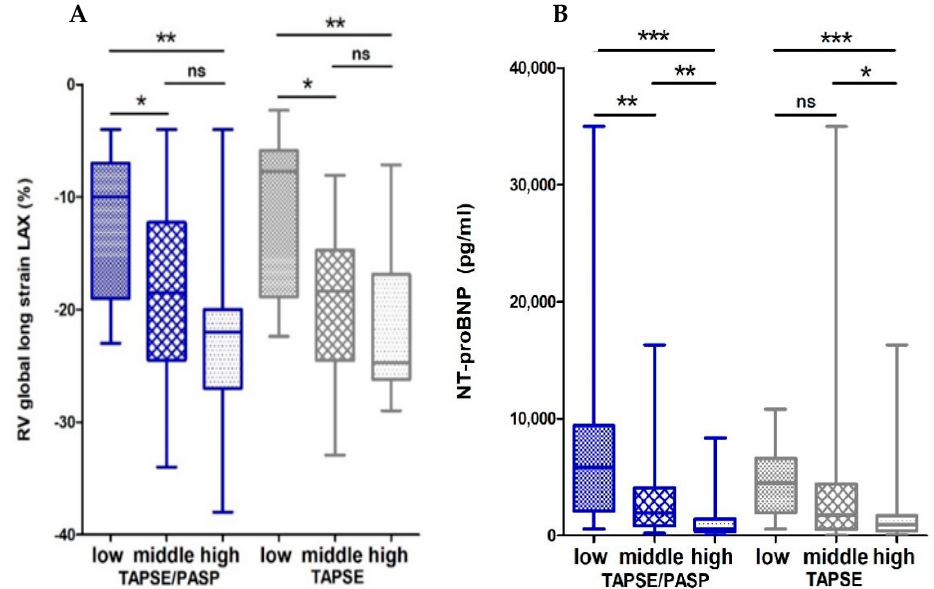
Figure 2. Box plots showing RV global longitudinal strain and NT-proBNP values of TAPSE/PASP and TAPSE tertiles. Shown are values for ( A ) long axis RV global longitudinal strain and ( B ) NT-proBNPdivided according to TAPSE/PASP and TAPSE tertiles. Boxes represent median with IQR. ns, not significant, * p < 0.05, ** p < 0.01, *** p < 0.001.